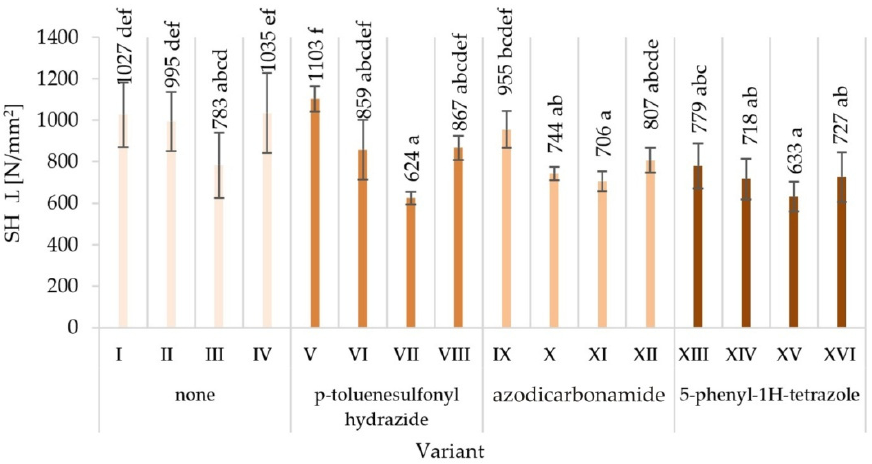
Figure 7. Screw holding perpendicular to the surface (SH ⊥ ) of particleboards produced (means and